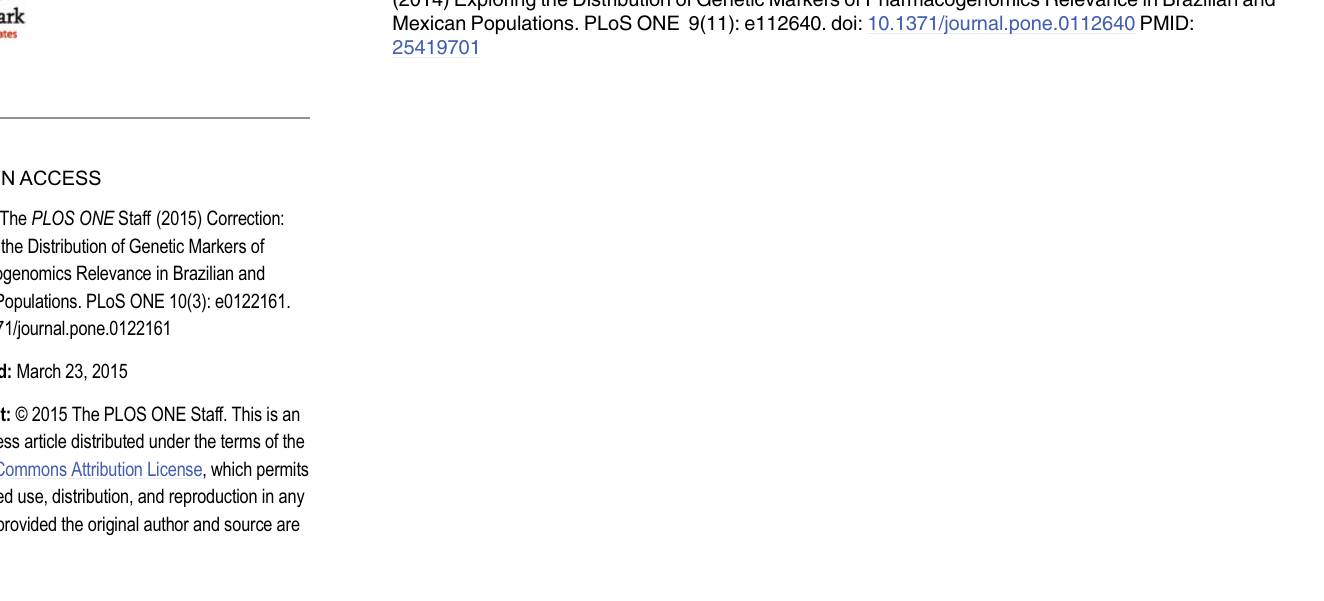
S5 Table. Supplementary dataset. Minor Allele Frequencies (MAF) for 1,647 genetic markers. The markers are those included in the DMET Plus array and for all populations: Europeans (Hapmap CEU), Africans (Hapmap YRI and LWK), Native Americans (Zapotecas), Brazilians and Mexican mestizos (Guanajuato (GUA); Guerrero (GUE); Sonora (SON); Veracruz (VER) and Yucatan